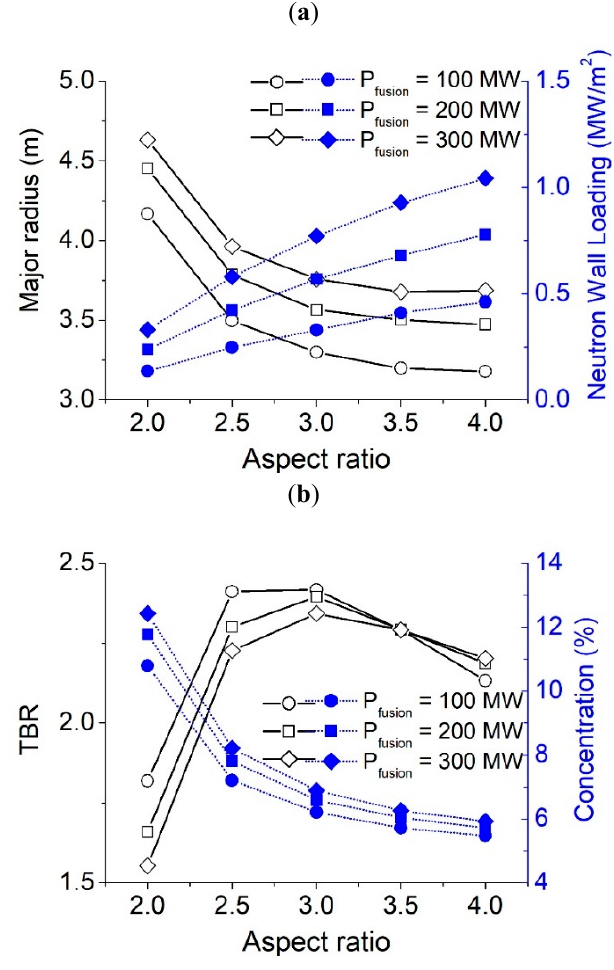
Figure 2. The impacts of the aspect ratio on ( a ) the minimum R 0 and the neutron wall loading; ( b ) initial TBR and initial TRU concentration for FLiBe.